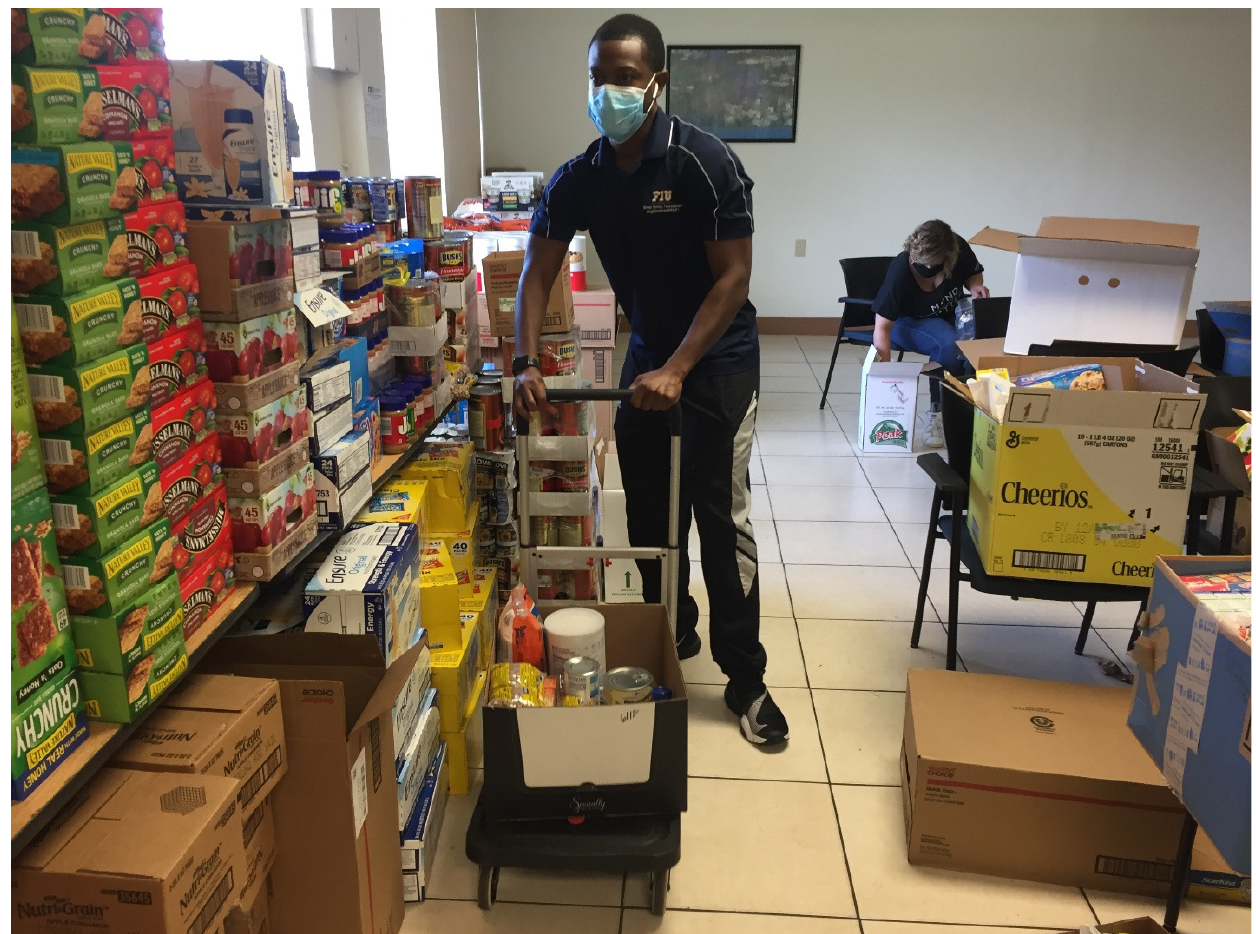
Figure 2. Food Packaging Distribution Location.